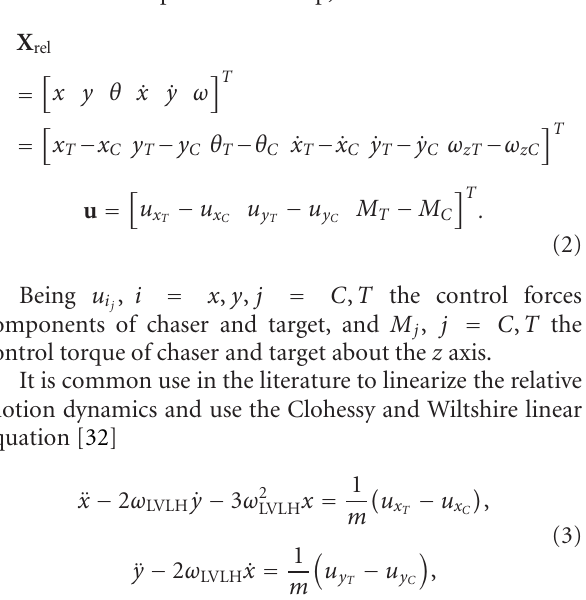
encompasses both the relative translation (two degrees of freedom) and rotation (one degree of freedom). We will refer in the following to a Local Vertical Local Horizontal (LVLH) reference frame (Figure 6) that rotates with the orbital angular velocity ω LVLH . The origin of LVLH moves on a virtual orbit, conveniently chosen to remain in the vicinity of the maneuvering spacecraft. This point can also be chosen as coincident with one of the spacecraft. The x -axis points from the center of the Earth to the center of LVLH, while the y -axis is in the orbital plane in the direction of the motion along the orbit and perpendicular to the x -axis. The z -axis completes the right-handed LVLH